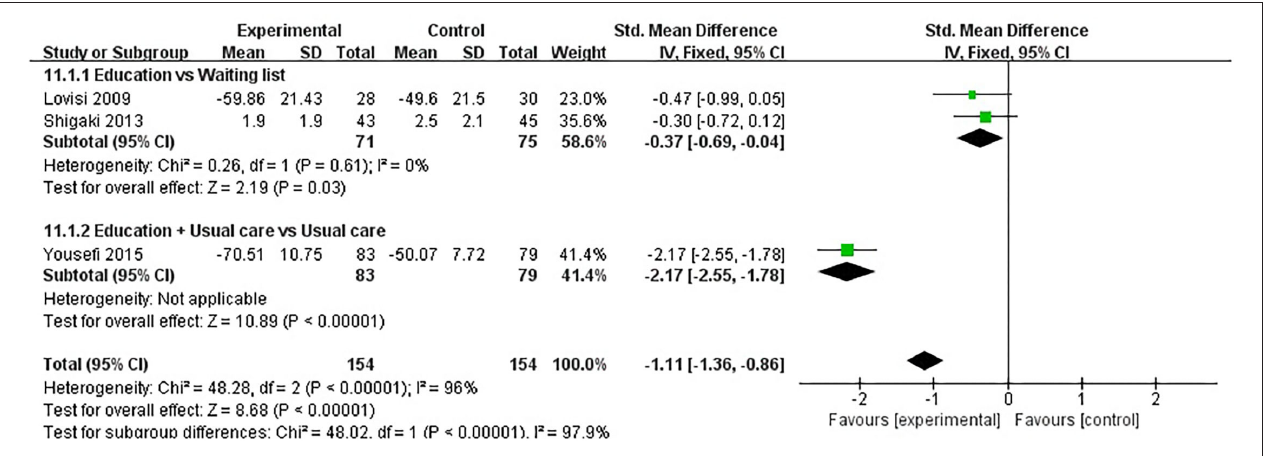
FIGURE 12 | Meta-analysis on General